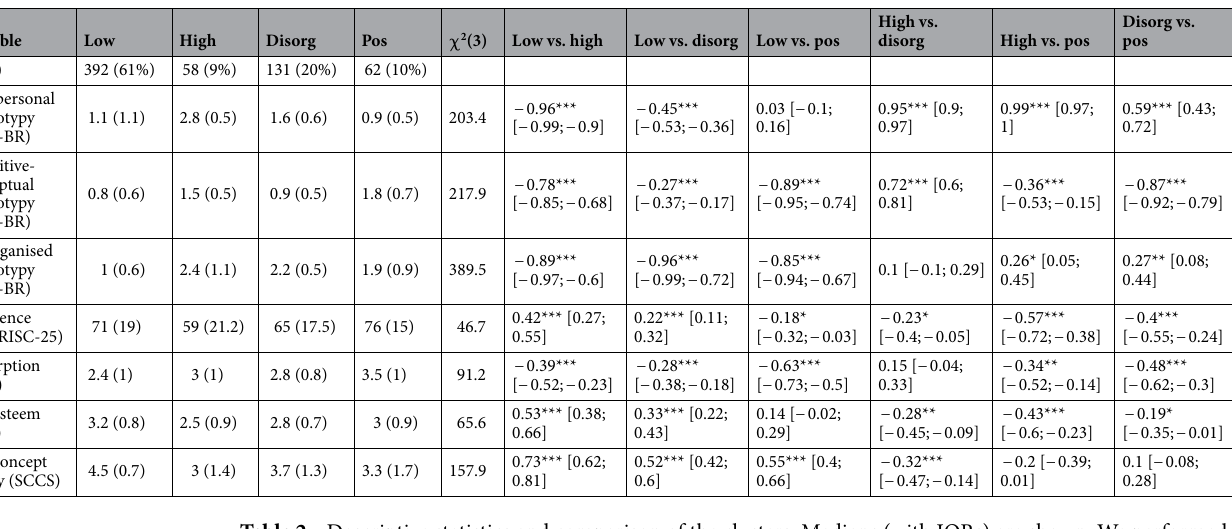
Table 2. Descriptive statistics and comparison of the clusters. Medians (with IQRs) are shown. We performed Kruskal–Wallis tests (all p values < 0.001), which were followed up by pairwise Mann–Whitney tests. For the comparisons, Cliff’s Delta is shown as an estimate of effect size with 95% confidence intervals in brackets. Pairs in the header indicate which clusters are compared: low = low schizotypy; high = high schizotypy; disorg = low positive, high disorganised and intermediate interpersonal schizotypy; pos = high positive, intermediate disorganised and low interpersonal schizotypy. *** p < 0.001; ** p < 0.01; * p < 0.05.